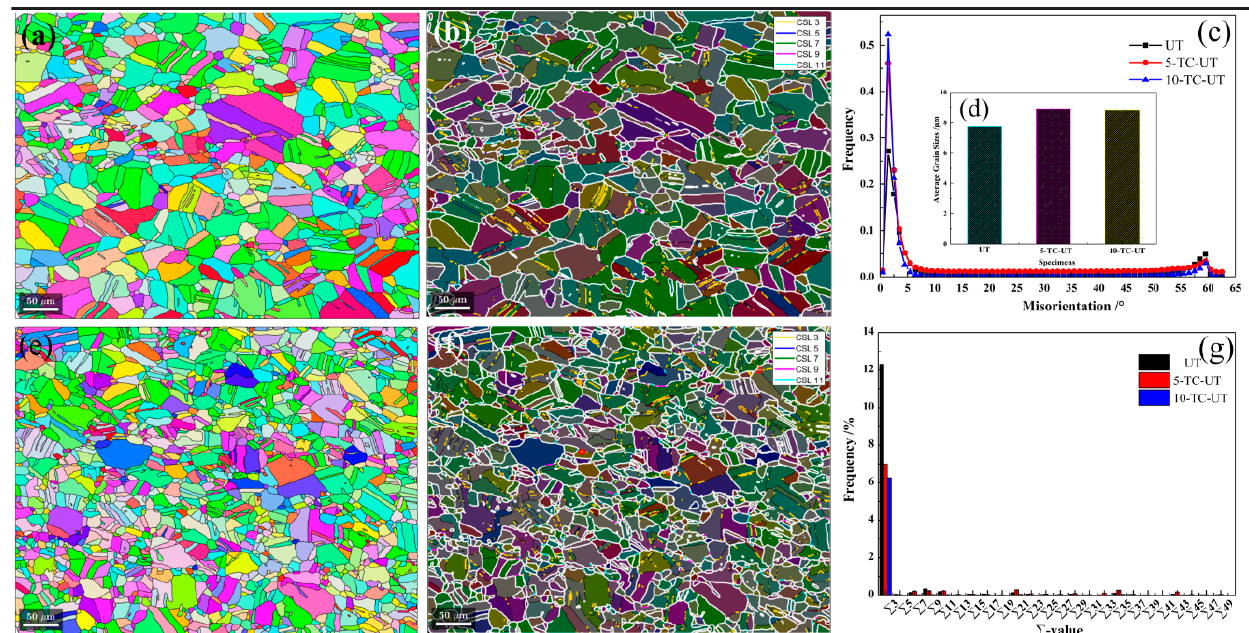
Figure 3. ( a , e ) EBSD IPF images of the 5-TC-UT and 10-TC-UT specimens; ( b , f ) CSL boundaries of the 5-TC-UT and 10-TC-UT specimens; ( c , d ) grain misorientation distribution and grain size of the UT, 5-TC-UT and 10-TC-UT specimens; ( g ) ∑ boundaries distribution histogram of the UT, 5-TC- UT and 10-TC-UT